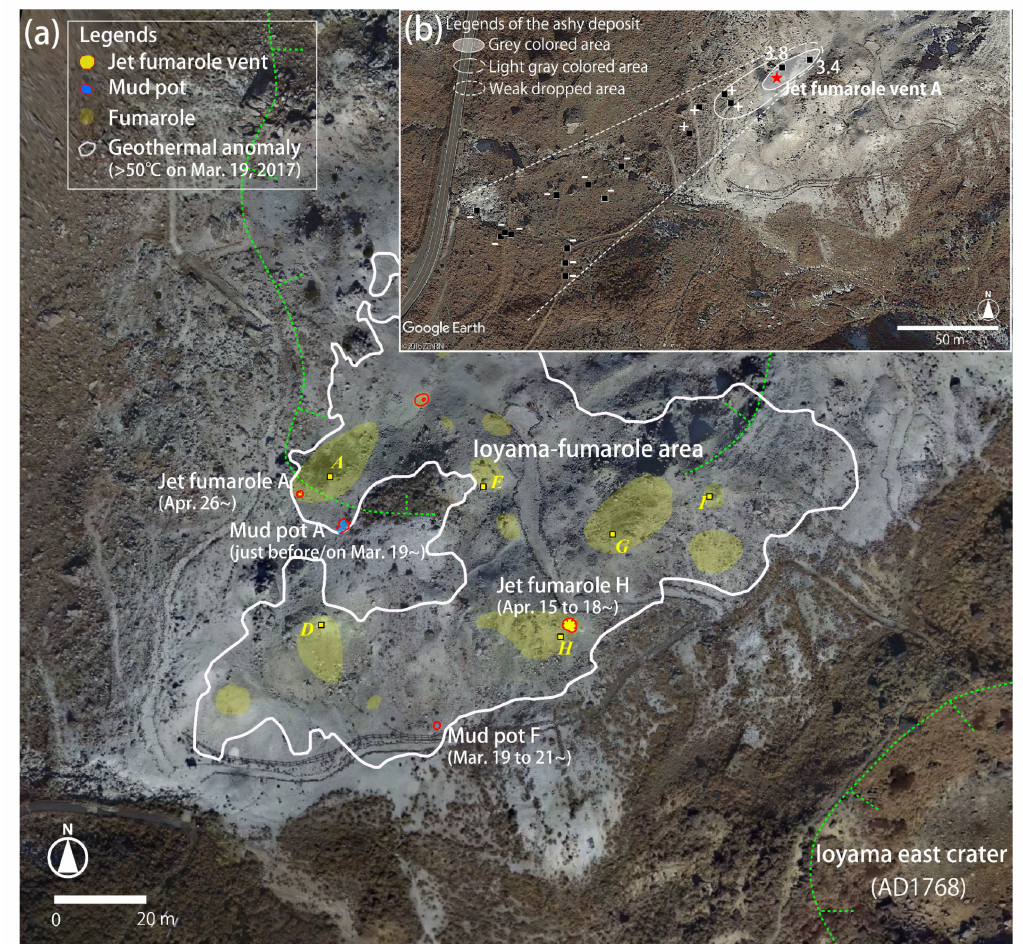
Figure 6. Drone and satellite map of the Ioyama-fumarole area. ( a ) Locations of mud pot A, jet fumarole vent A, mud pot F and jet fumarole vent H. Observation points are indicated by italic alphabet.; ( b ) Distribution of ashy deposit from the jet fumarole vent A on a Google Earth map [45]. + : coated, -: visible, two values of ashy deposit weight per a square (kg / m 2